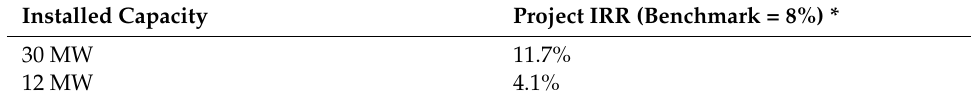
Table 4. IRR of the BCPG projects with different installed capacities in